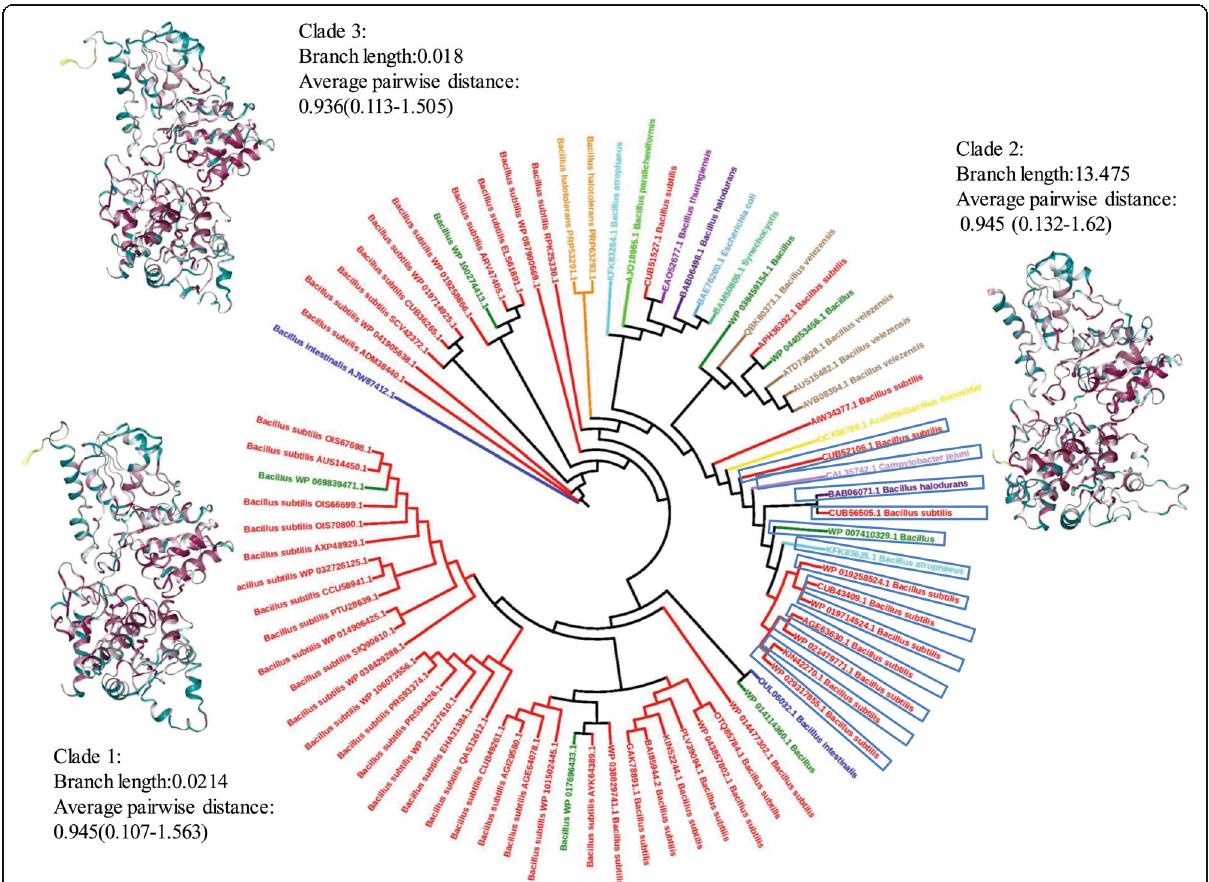
Fig. 8 Phylogenetic tree of 76 sequences of DXP synthase proteins in Bacillus subtilis. The 13 transketolase sequences are marked with blue squared boxes, and it shows a clear segregation of the two